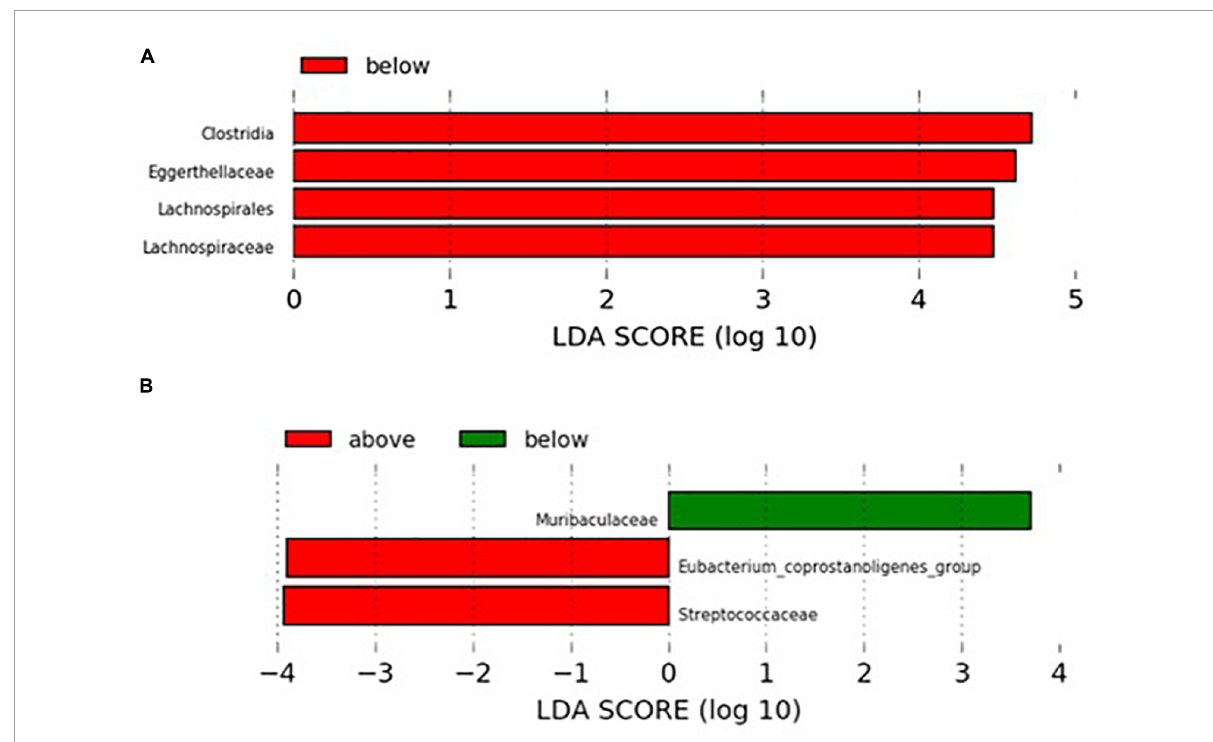
FIGURE3 LEfSe analysis of microbial taxa differentially altered as a function of safety intake thresholds for some xenobiotics. (A) MeIQx at levels below ( n = 11) or over ( n = 8) the risk dose (50 ng/day) (54) and (B) PhIP at levels below ( n = 12) or over ( n = 7) the risk dose (40 ng/day) (54). Only families with relative abundance of at least 1% in at least two samples were considered in the